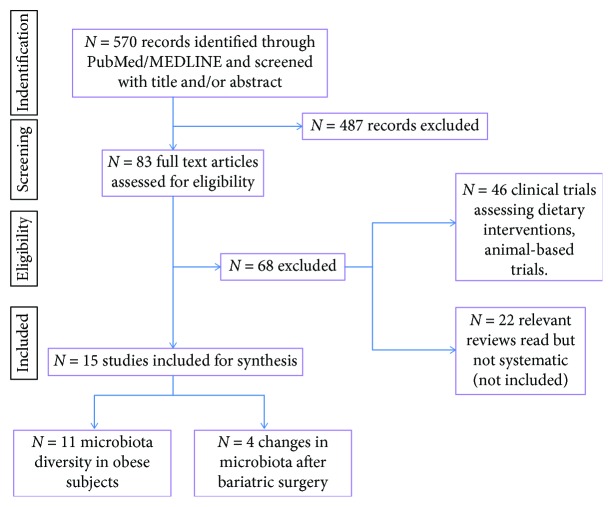
PRISMA flow diagram.